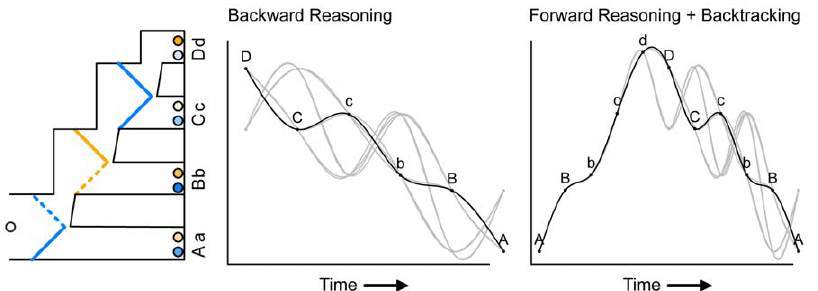
Figure 5. An example second-order Marble Drop game (left panel), and associated fixation sequences predicted on the basis of backward reasoning (middle panel) and forward reasoning plus backtracking (right panel). The fixation sequences represented by the black lines are annotated for AOI (A – D; a – d), and those represented by the grey lines are not. Player 1 9 s payoffs are labeled with uppercase A, B, C, and D. Player 2 9 s payoffs are labeled with lowercase a, b, c, and d. The sequences are depicted on ‘‘eye movement paths’’ for illustrative purposes.